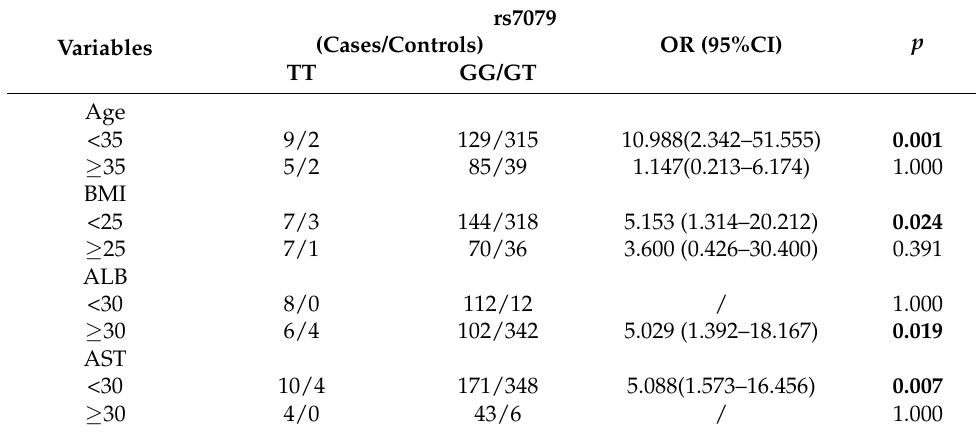
Table 4. Stratified analysis for PE susceptibility and AGT rs7079 G >